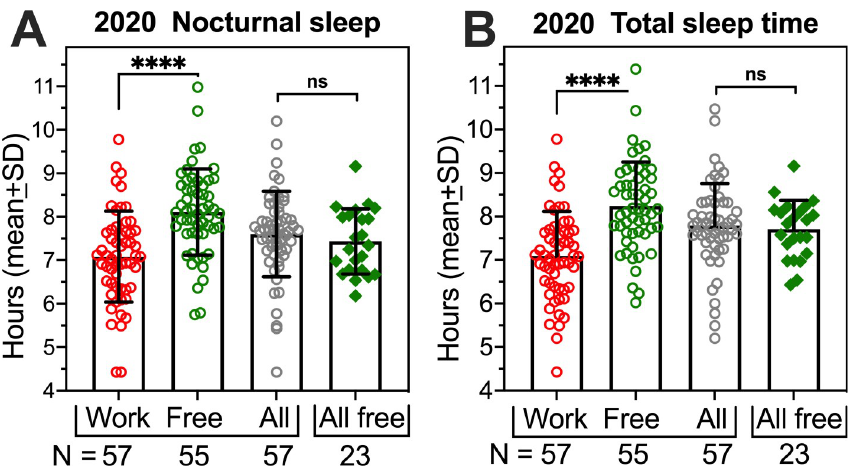
Fig 4. Nocturnal sleep duration (A) and total daily sleep duration (B) of participants in the 2020 group who had work days (N = 57) or only free days (N = 23). Paired t-tests for comparisons of work and free days, and unpaired t-tests for comparisons of average sleep across all days in those with work and free days (’all’) and those with only free days (’all free’). ���� p <